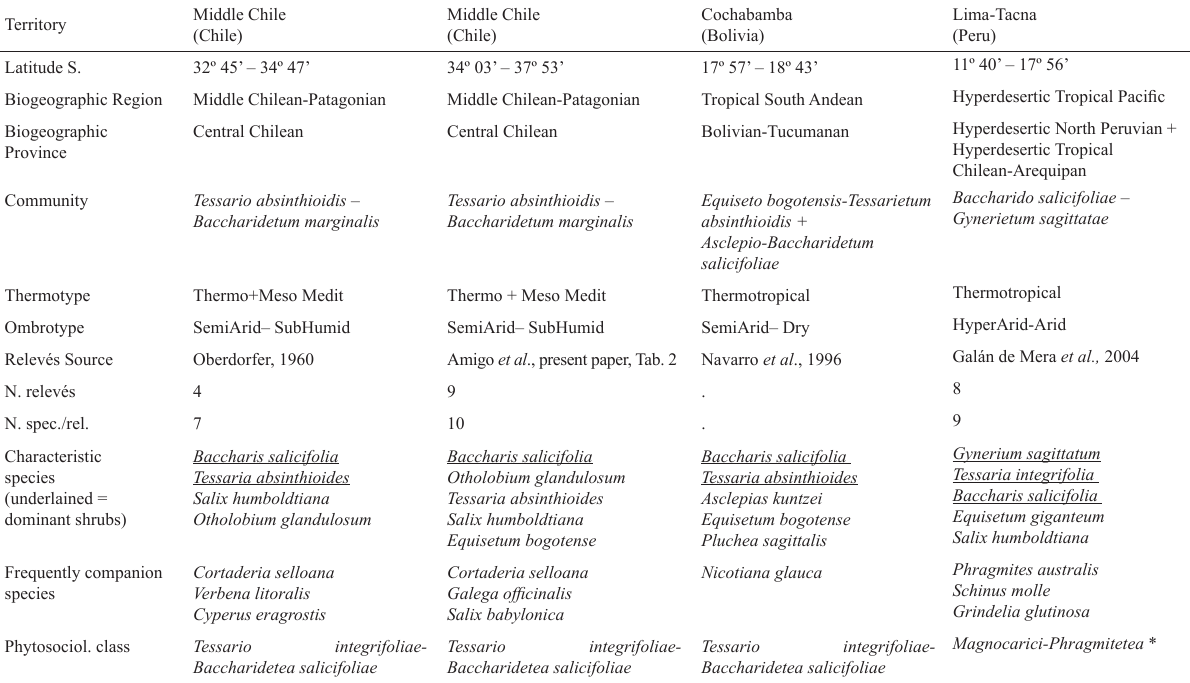
Middle Chile (Chile)